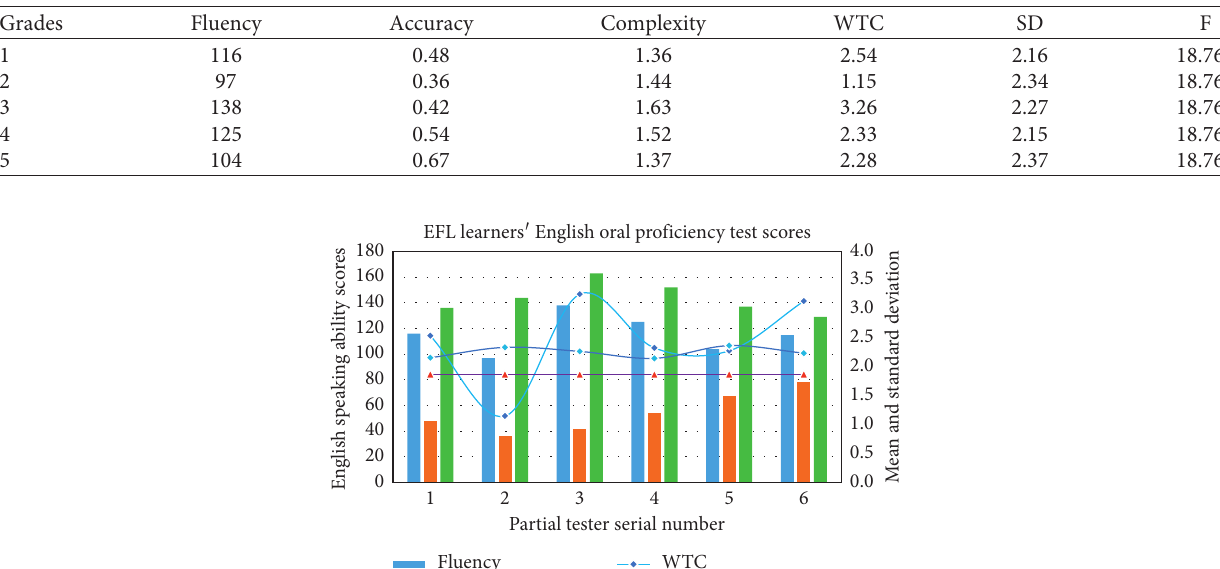
Table 3: EFL learners’ English oral proficiency test